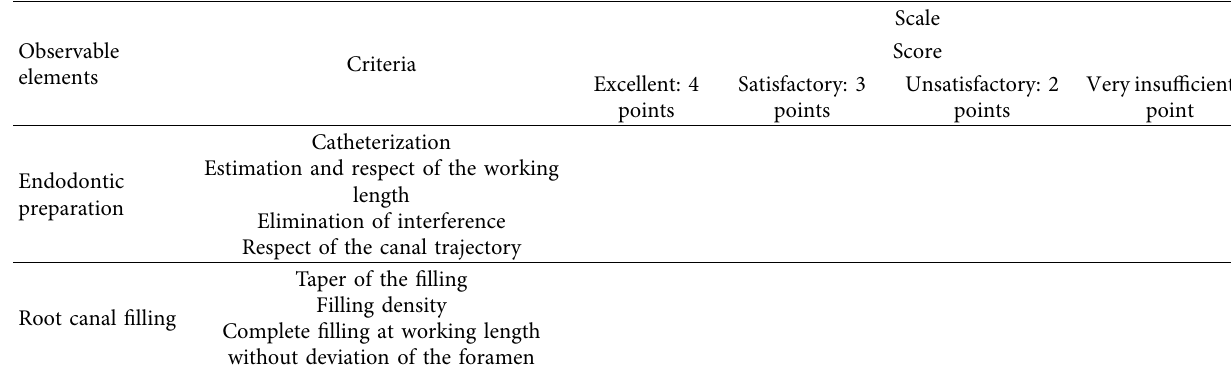
Table 2: Preparation and endodontic filling evaluation